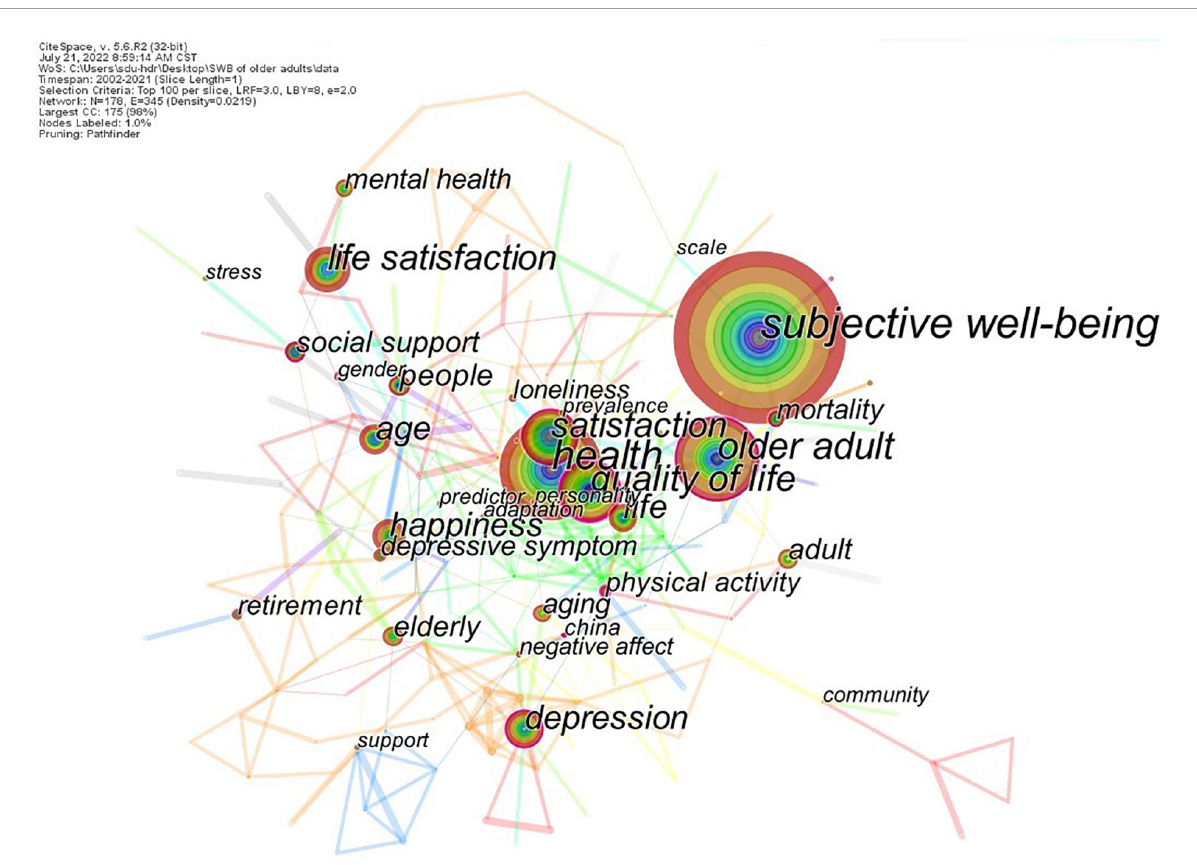
FIGURE8 Co-occurrence network of keywords. A circle represents a keyword, and the size of the circle represents the frequency of occurrence. The connection between nodes represents the cooperation relationship, and the thickness of the connection represents the frequency of cooperation. The purple edge of the node indicates high betweenness centrality ( ≥